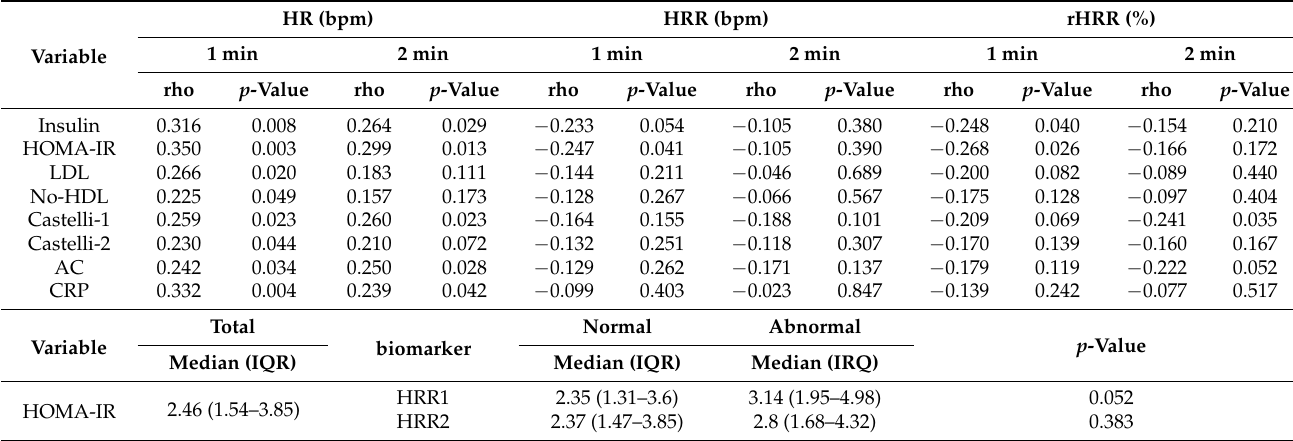
Table 6. Correlation between heart rate, heart rate recovery at 1 and 2 min, relative heart rate recovery, blood chemistry parameters and atherogenic indices. Comparative differences in HOMA between normal and abnormal HRR.